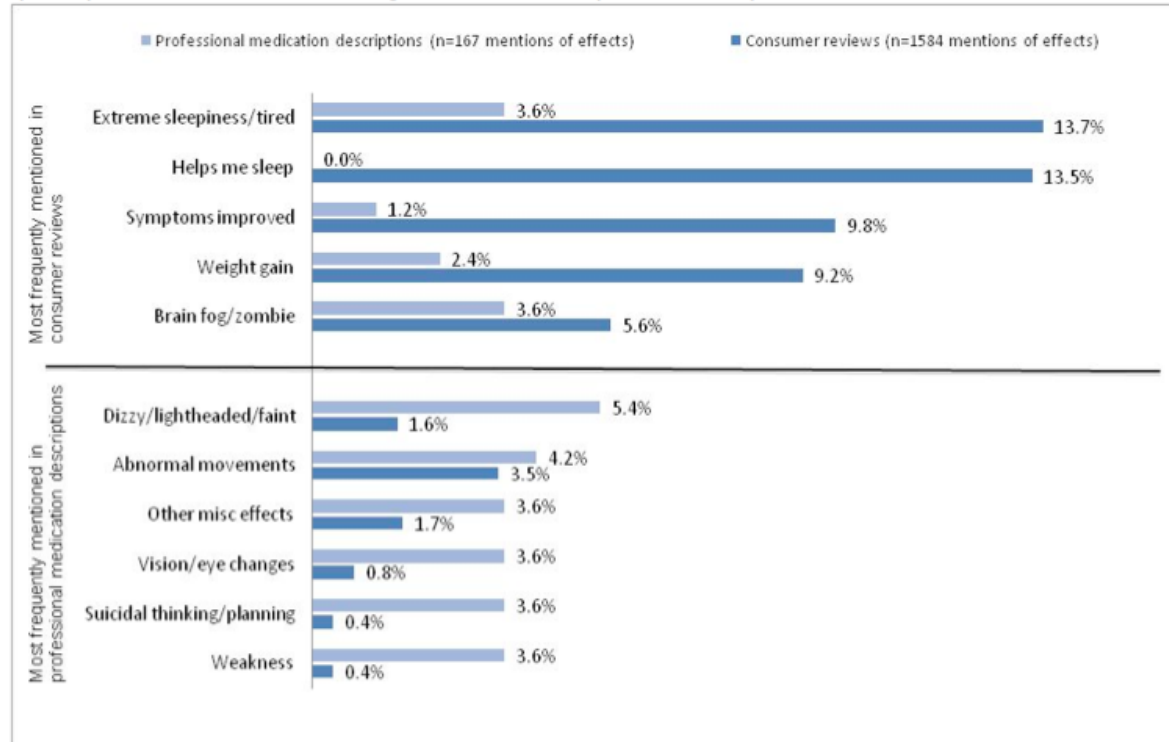
Figure 3. Most frequently mentioned effects as a proportion of all mentions of quetiapine effects in consumer-generated and in professionally controlled